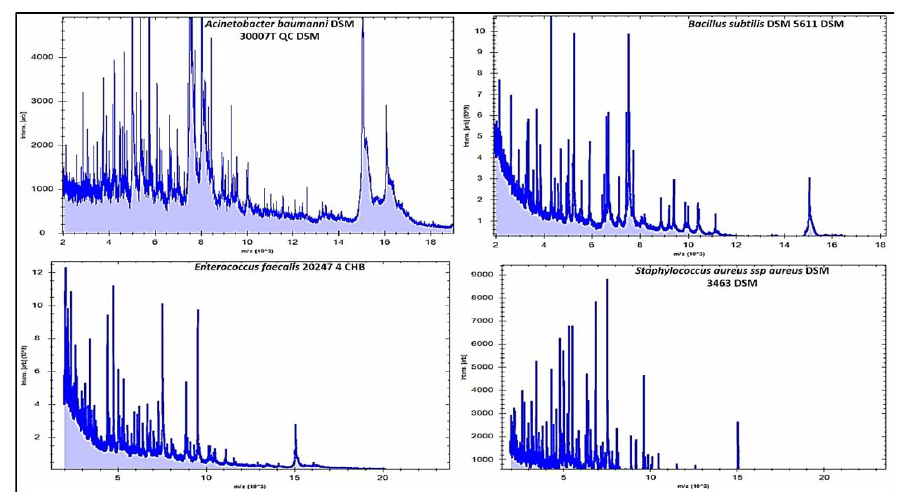
Fig. 3. MBT mass spectra of overnight cultured gram-positive bacteria ( Acinetobacter baumanni, Bacillus subtilis, Enterococcus faecalis and Staphylococcus aureus ) isolated from air